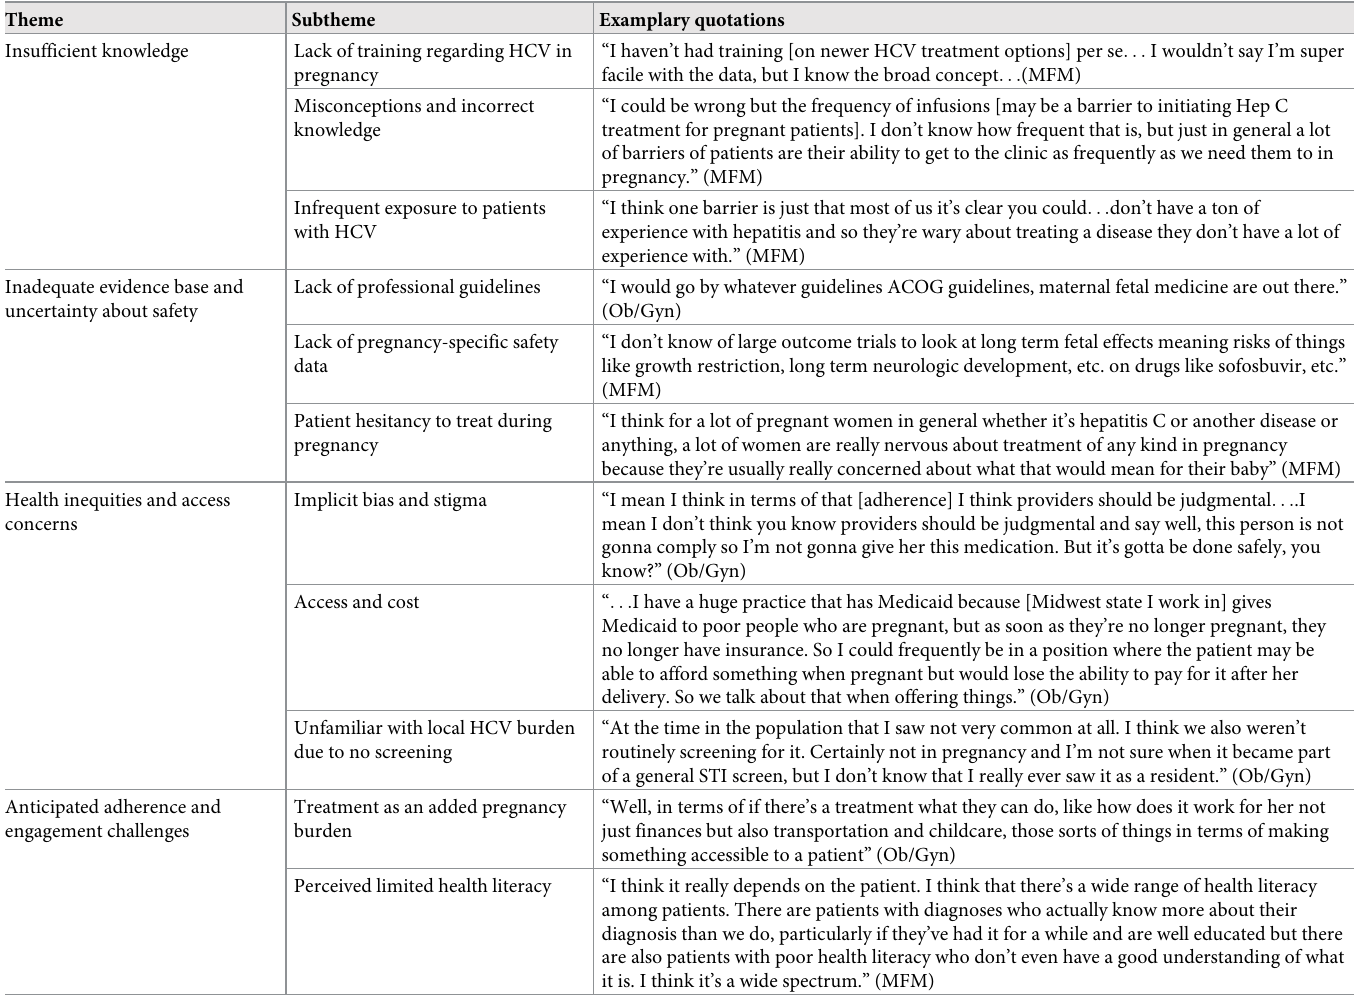
Table 2. Obstetrician perceptions of barriers to treatment of HCV during